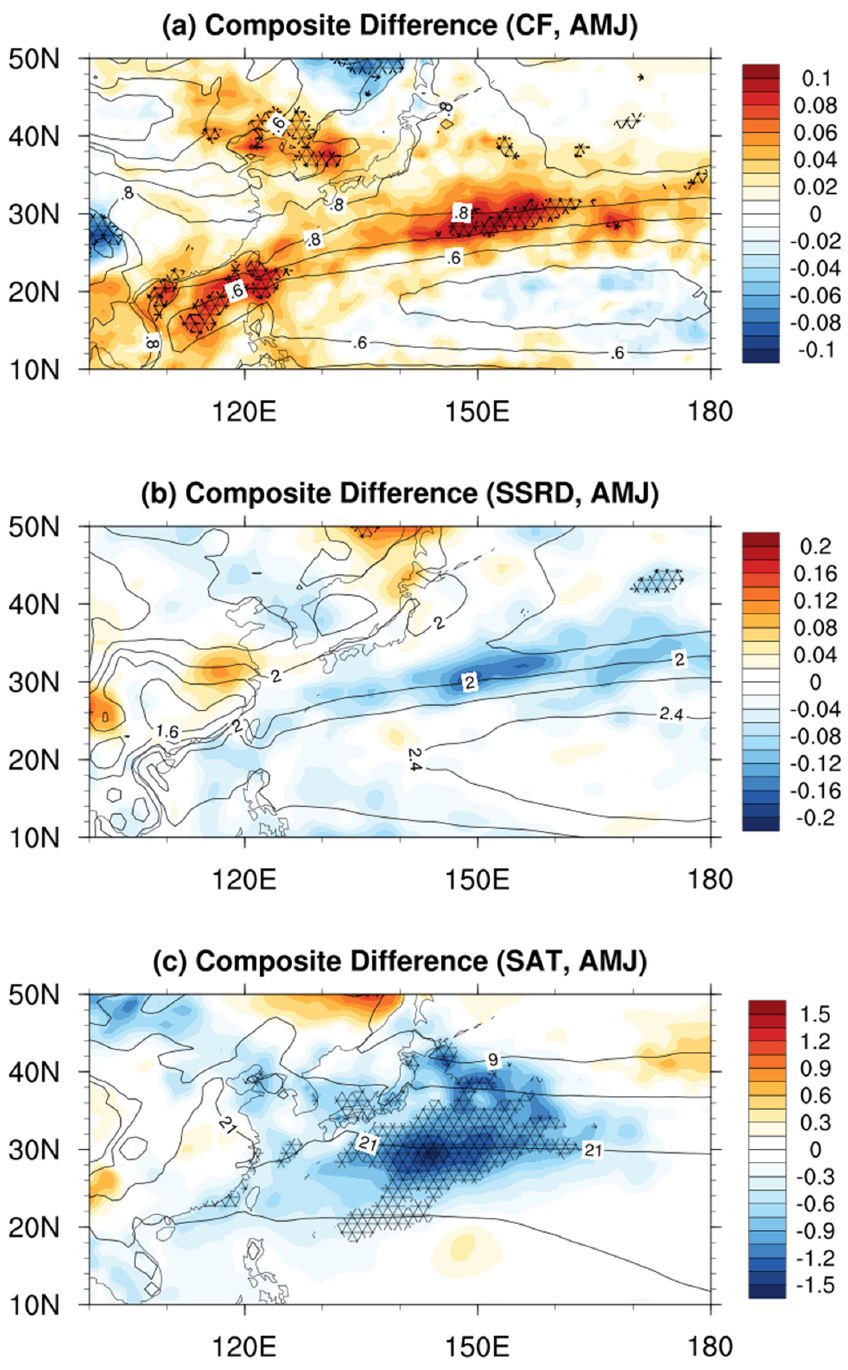
Figure 2. The composite difference between high AOD and low AOD of ( a ) AMJ cloud fraction (CF), ( b ) AMJ surface net solar radiation (SSRD; 10 − 7 J / m 2 ), and ( c ) AMJ surface air temperature (SAT; ℃ ). Regions with black cross-hatching indicate a statistical significance at a 95% confidence level. Solid black lines denote the climatological (2000–2017) mean.